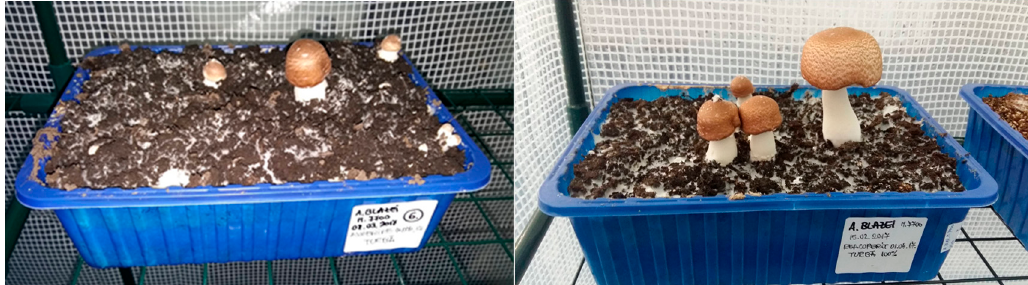
Figure B4. Coated cover layer with mycelium. Source: Photo original—SC CIUPERC Ă RIA SRL, Aghiresu-Fabrici, Cluj County.